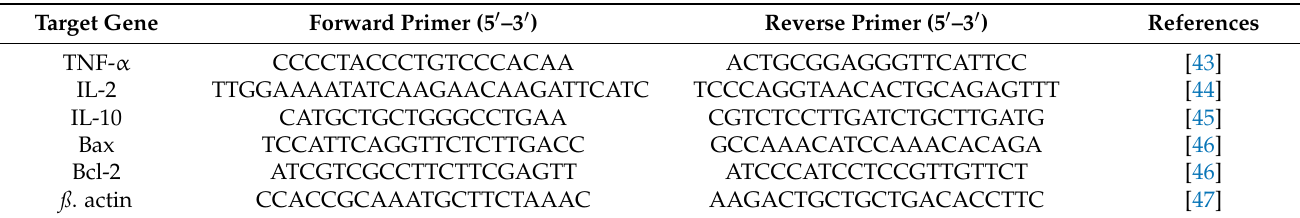
Table 2. Primer sequences of gene analyzed in real-time